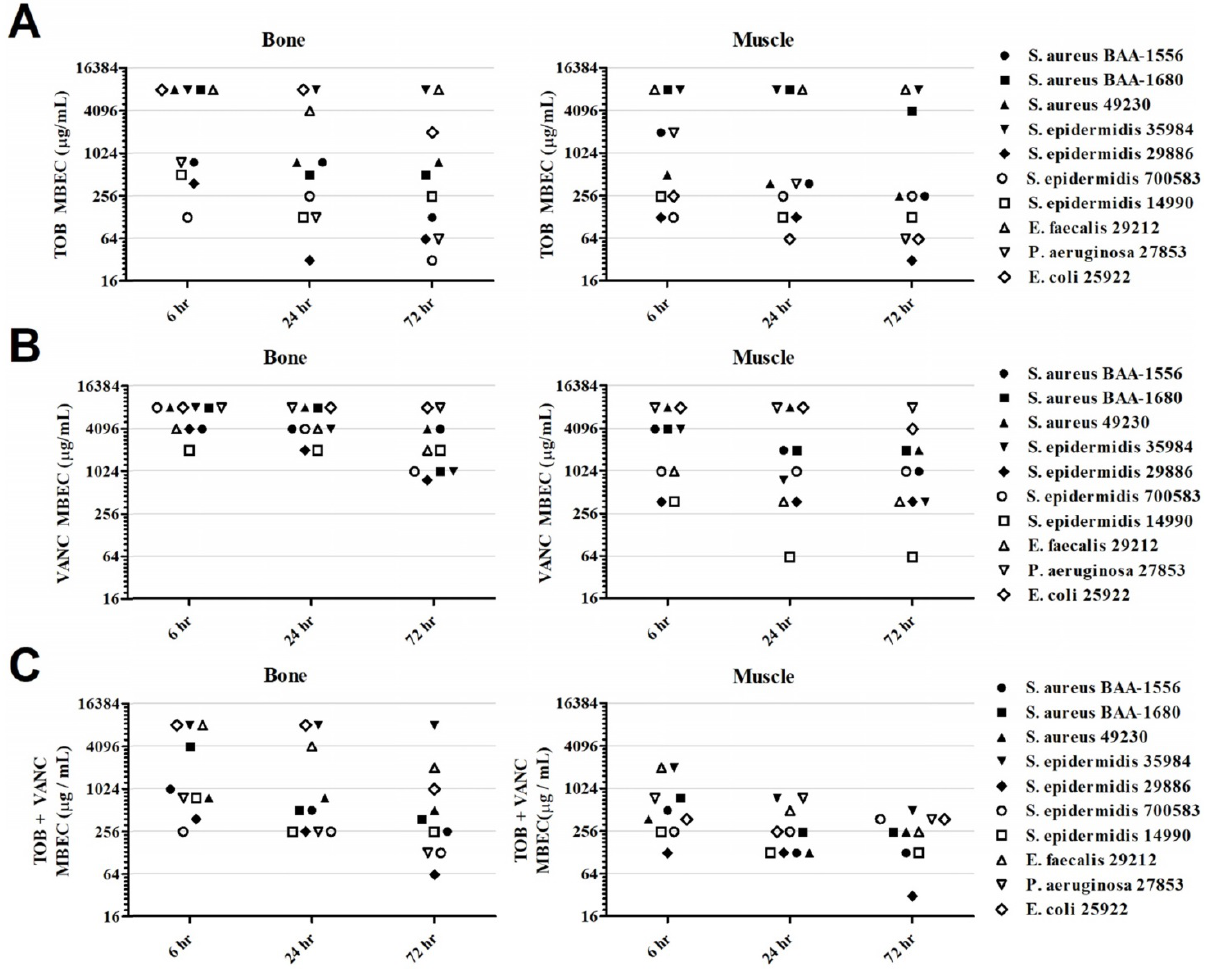
Figure 2. MBEC for 10 musculoskeletal biofilms on bone (left column) and muscle (right column) tissue treated with (A) tobramycin, (B) vancomycin, or (C) tobramycin/vancomycin combination for 6 to 72 hr (see also Table S1).